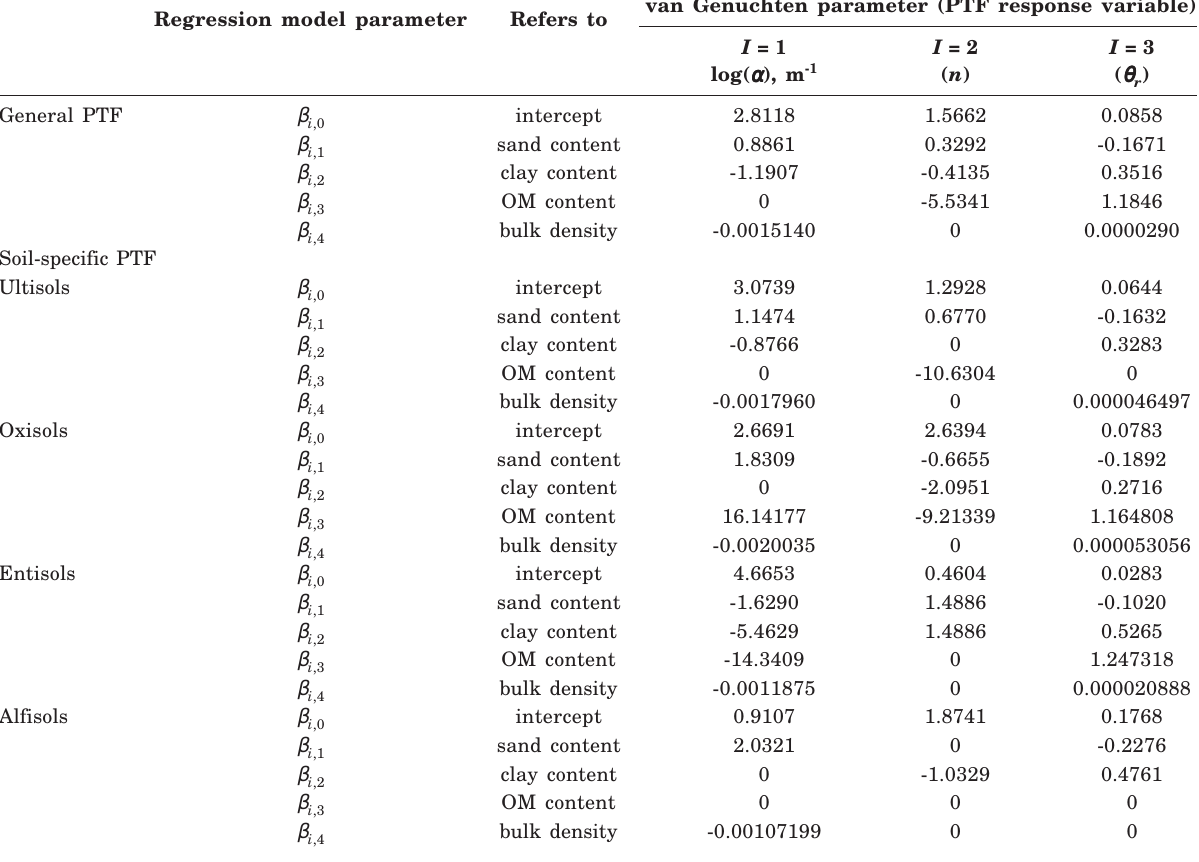
Table 4. Estimates of linear multiple regression parameters for general PTF- 4v as well as for soil-class- specific PTF- 4v , obtained from the development subset ( N =